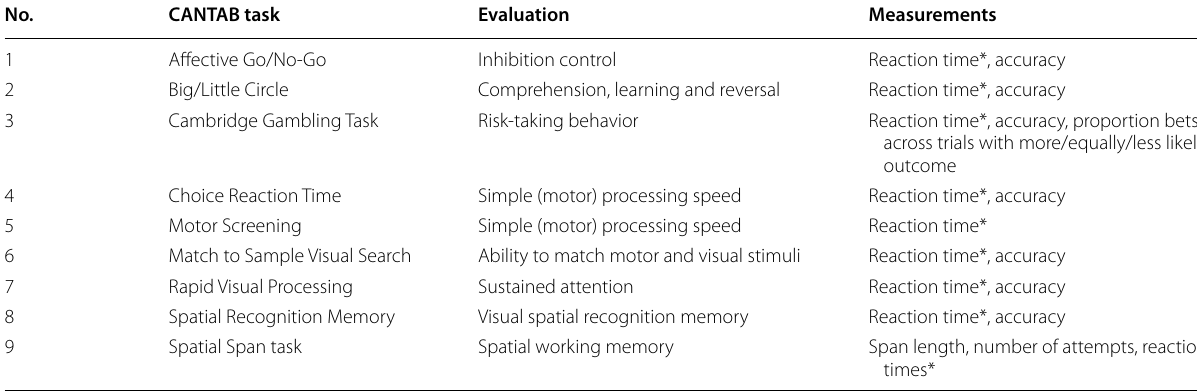
Table 1 Cognitive tasks and measurements